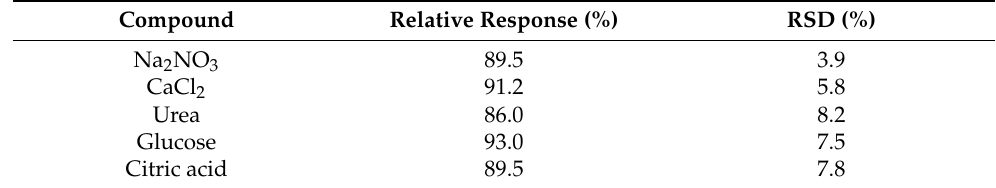
Table 2. Relative response (%) for 20 µ M of nitrite in the presence of potential interfering compounds.